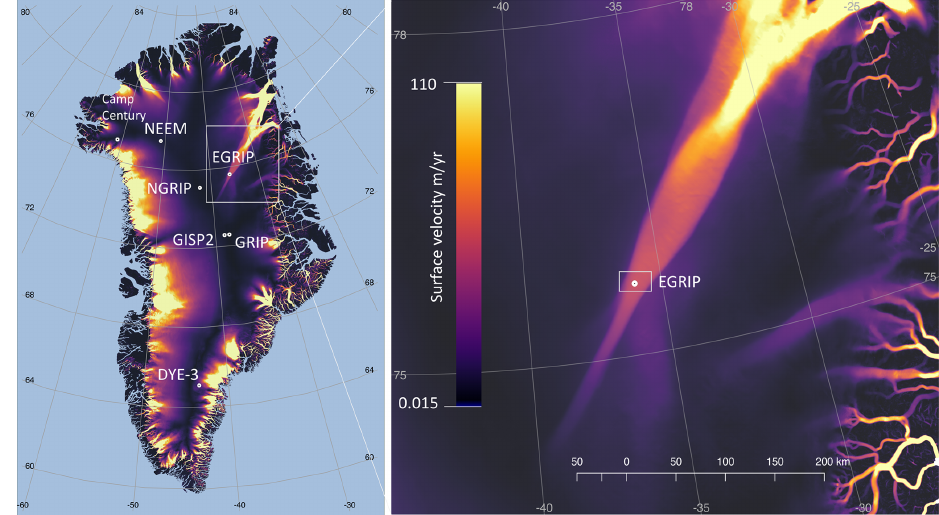
Figure 1. Locations of deep ice-core drill sites: EGRIP, NEEM, NGRIP, GRIP, GISP2, DYE-3 and Camp Century in Greenland, and close-up of the EGRIP drill site inside the Northeast Greenland Ice Stream (NEGIS). Colours show surface flow velocities from satellite data (Joughin et al.,